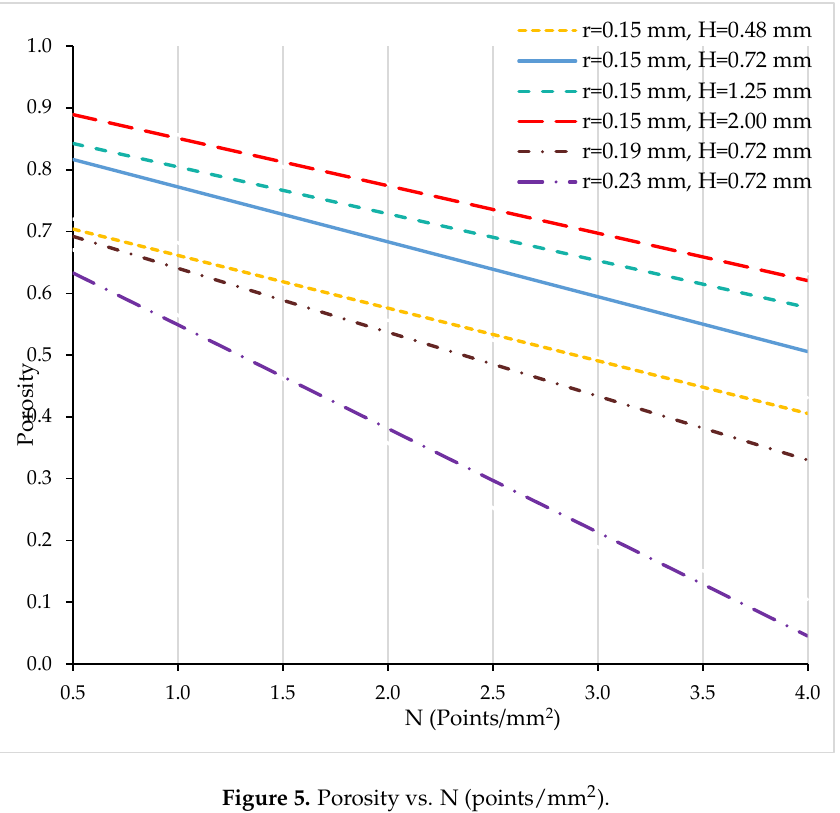
Figure 5. Porosity vs. N (points/mm 2 ). Materials 2018 , 11 , x FOR PEER REVIEW